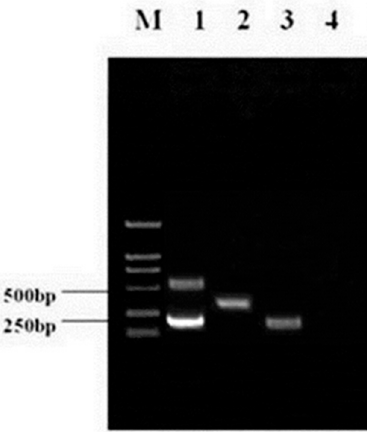
Figure 1. The results of multiplex RT-PCR in optimization conditions.Lane M, DL2000 DNA marker; lane 1, highly pathogenic porcine reproductive and respiratory syndrome virus (HP-PRRSV) strain JXA1-R; lane 2, classical PRRSV (C-PRRSV) strain CH-1a; lane 3, HP-PRRSV strain 07HBEZ; lane 4, ddH 2 O.